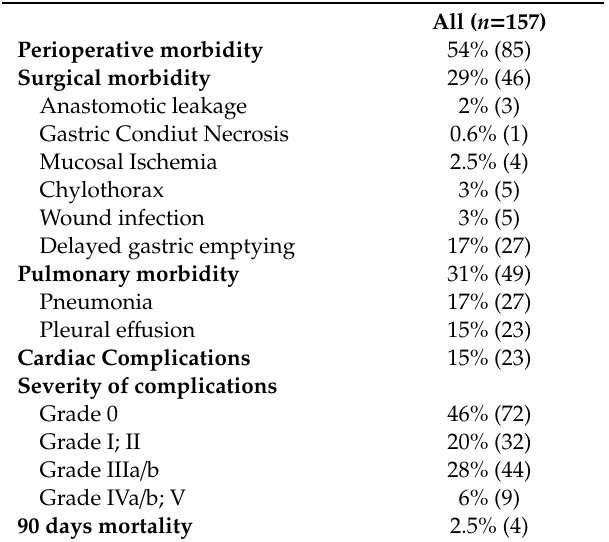
Table 3. Surgical outcome and postoperative